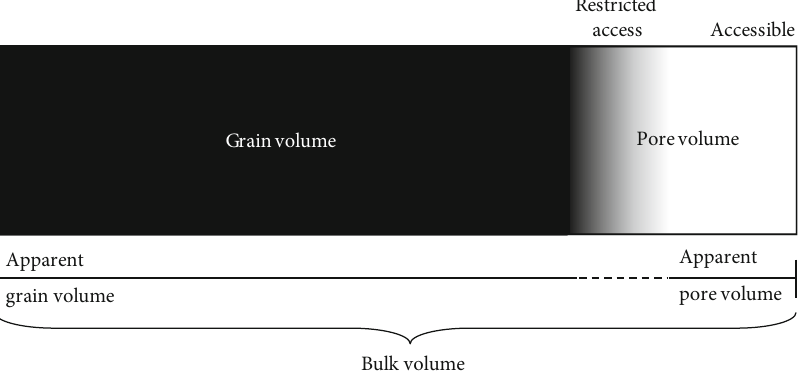
Figure 1: De fi nitions of bulk, grain, and pore volumes used in this